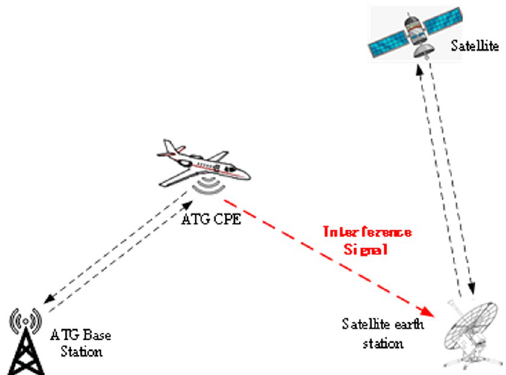
Fig. 5 Earth-space clutter loss between ATG and other